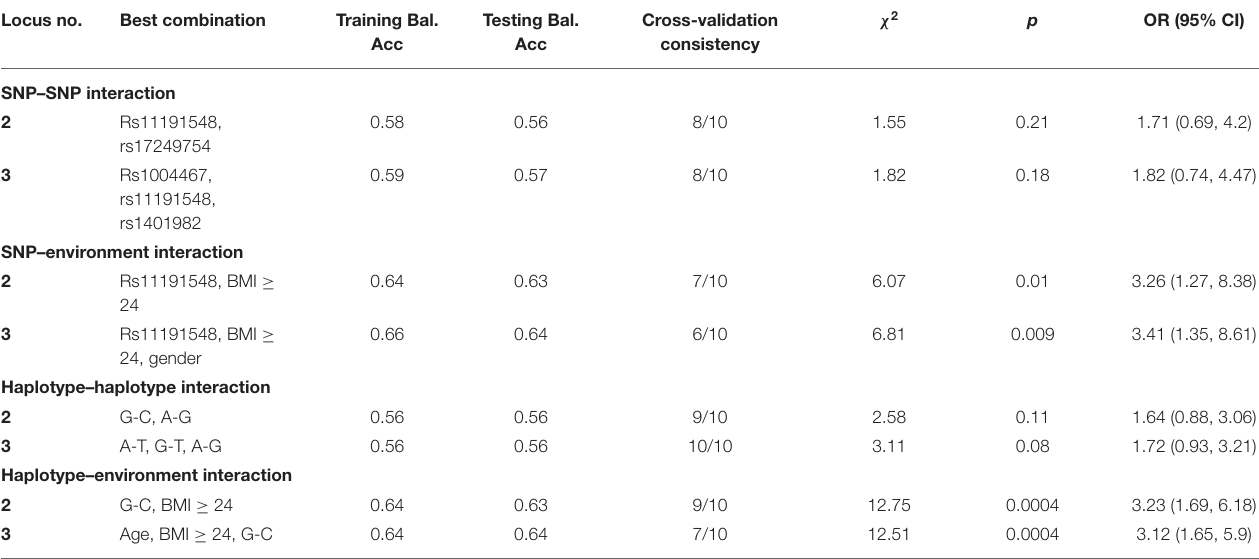
TABLE 4 | GMDR analysis of SNPs, haplotypes, and environments showed different interactions. Locus